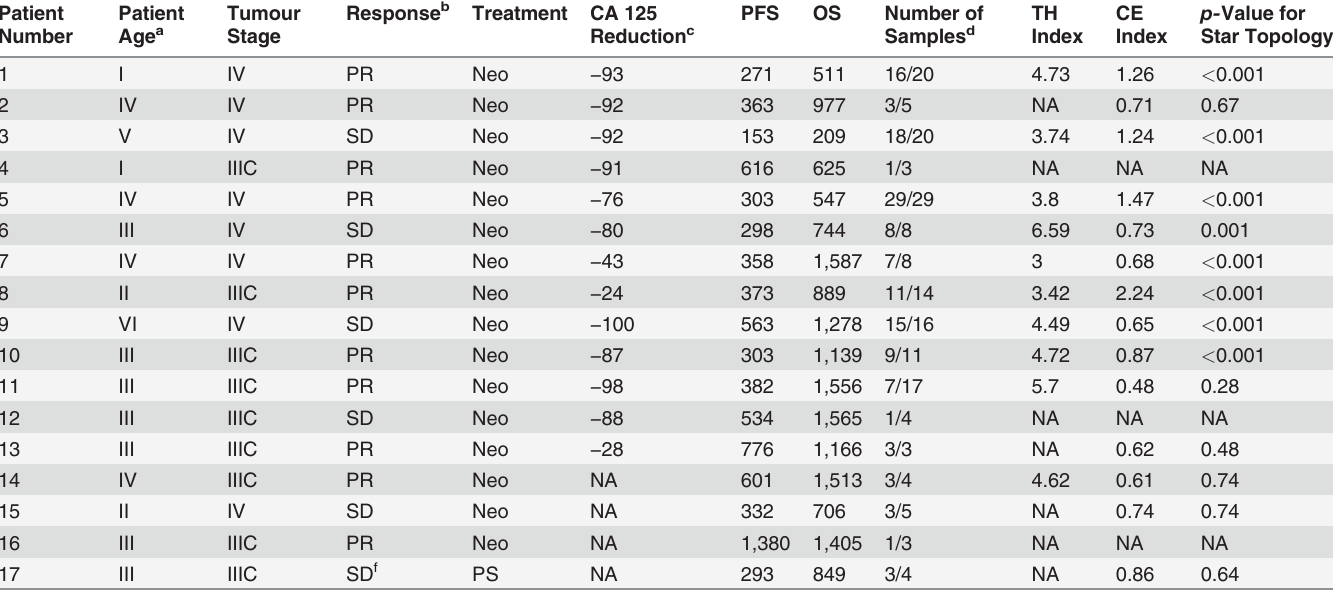
Table 1. Summary of samples from the CTCR-OV03/04 clinical